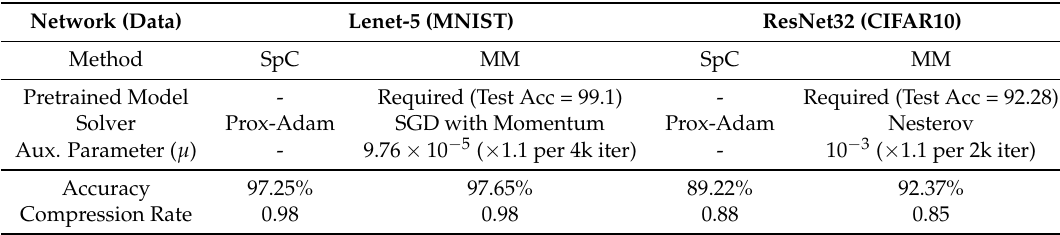
Table 2. Comparison between our method SpC and the state-of-the-art MM. For MM, we used the hyperparameters and the best pretrained models as a starting point following the original paper [33]. Note that our method SpC starts from random weights and does not require complicate control of the auxiliary parameter µ